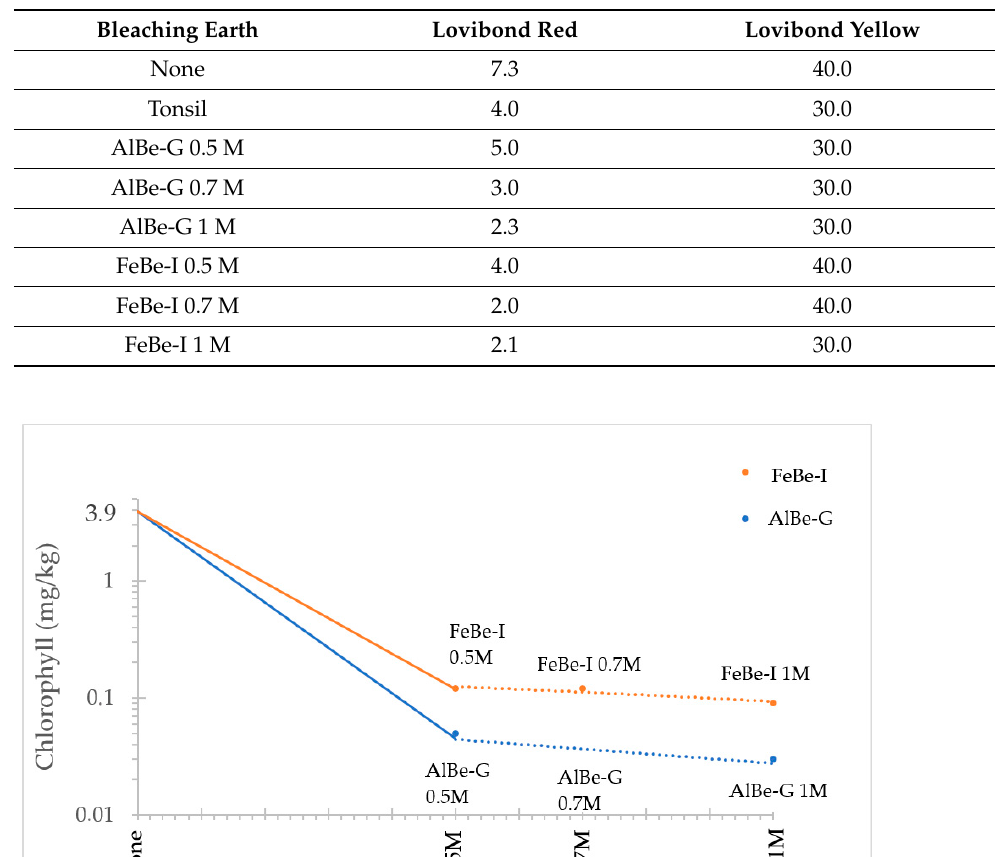
Table 5. Lovibond red and yellow of untreated and bleached oil samples (80 ◦ C, t = 30 min, 250 rpm, 3% w / w ).